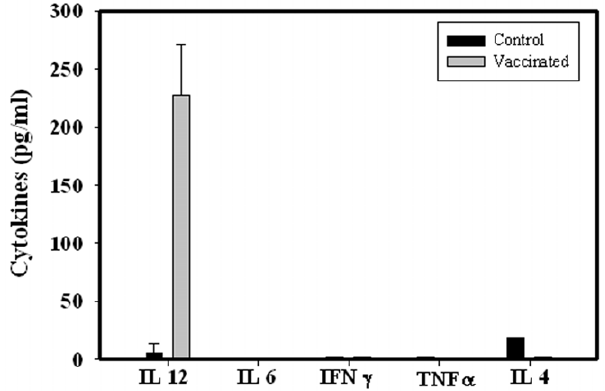
Figure 6. Th1 and 2 cytokine levels in vaccinated than unvaccinated non-pregnant mice. Vaccinated and unvaccinated mice were sacrificed and checked for the cytokine profile. IL-12 was significantly more in vaccinated mice as compared to the unvaccinated mice. There was no difference in other cytokine like IL-6, IL-4, TNF a and IFN c level in serum of Control and vaccinated mice. Data shows the representative of three independent experiments performed.